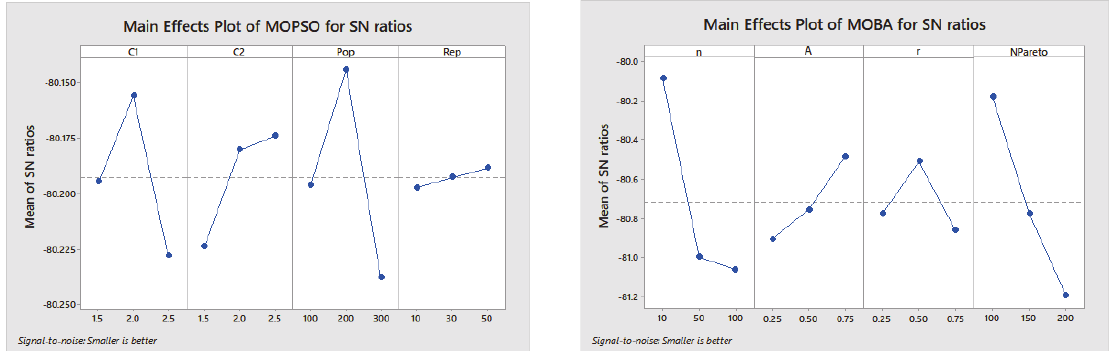
Fig. 5. Main effect plot of MOPSO and MOBA for S/N ratios (raw material inventory model)